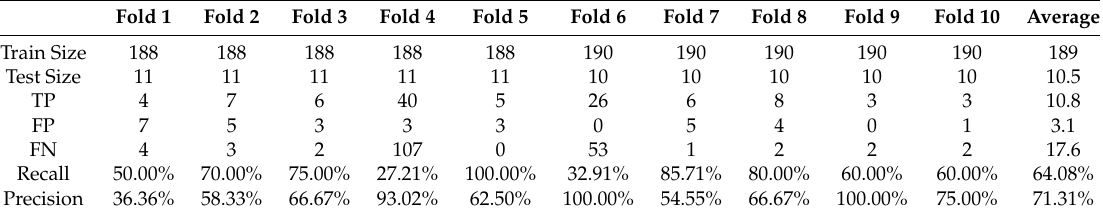
Table A13. The Results of Experiment 13: Augment the complete dataset containing images with and without dents (Dataset 6), by testing with the